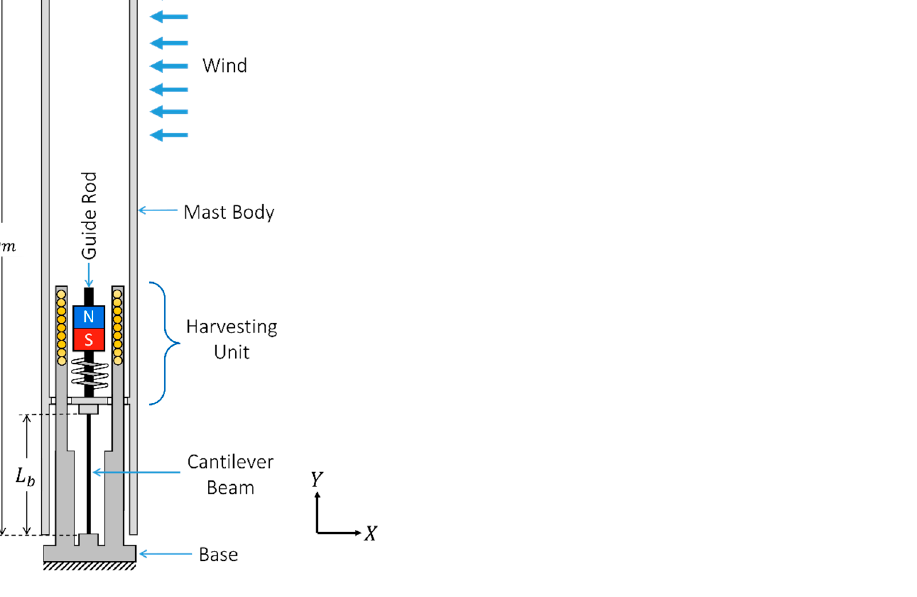
Figure 1. Schematic drawing of a vortex bladeless wind turbine with a tuning mechanism. The turbine is fixed at the base.